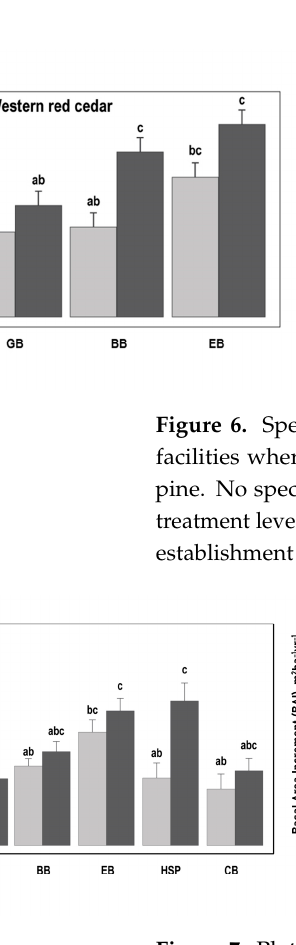
Figure 7. Plot means and standard error ( n = 5) for 2019-2021annual increments for ( a ) diameter increment; ( b ) basal area increment; and ( c ) volume increment. Same letters over bars indicate no differences between treatment levels at α = 0.10. Facility abbreviations are as described in Figure 2. Facilities are arranged in establishment order with GB being first (1978) and CB last (2013). Table 6. Growth increment analysis of covariance results. Plot mean diameter increment (DI), mean annual basal area increment (BAI) and mean volume increment (VI) for 2019–2021. Results include F -statistic ( F ) and p -values ( p ). Covariates for DI, BAI and VI were initial diameter (D 0 ), basal area (BA 0 ), and volume (V 0 ) measurements in